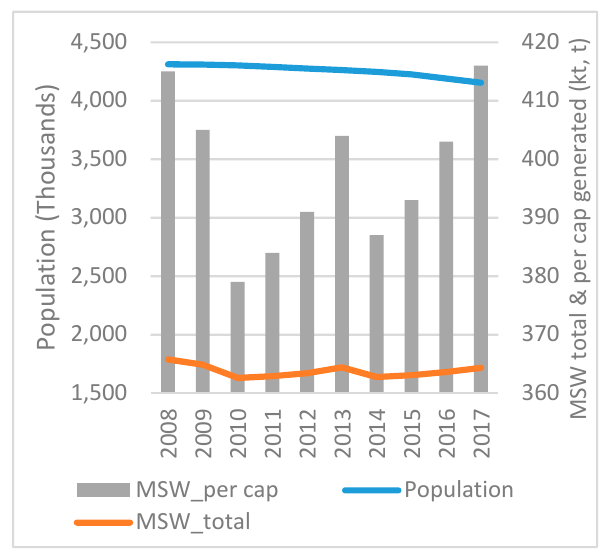
Figure 21. Population and MSW production in Croatia 2008–2017 (EUROSTAT 2019a, 2019c). Soc. Sci. 2019 , 8 , x FOR PEER REVIEW